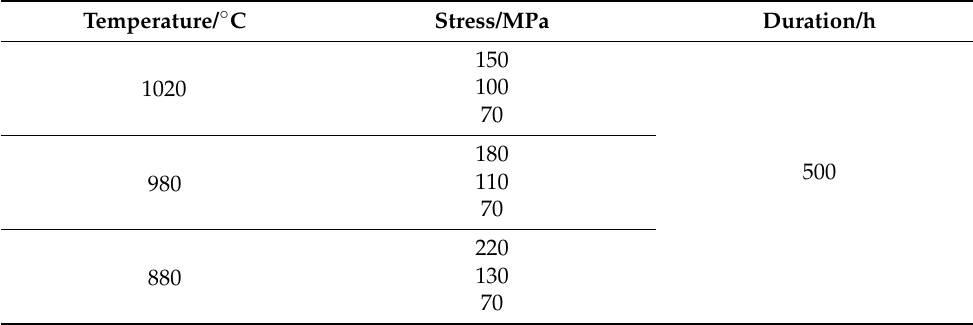
Table 1. The temperature and stress under the simulated service